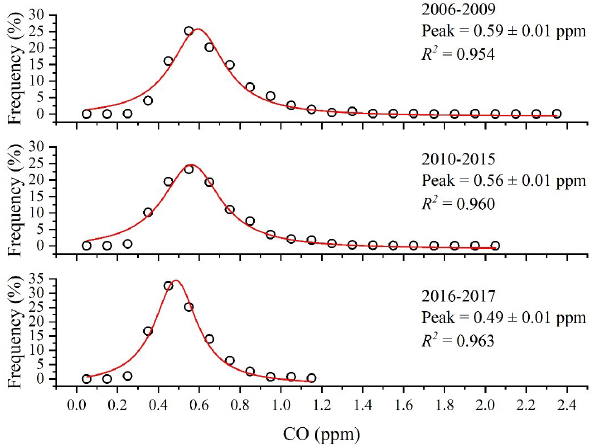
Figure 5. Variation in the annual mean CO mixing ratios at the LAN station from 2006 to 2017 (the error bars represent 1 standard devi- ation calculated from monthly means).